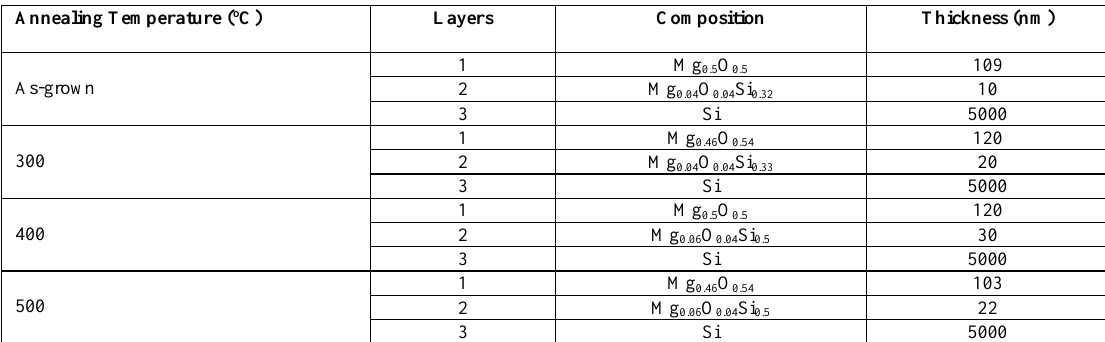
Table 2. Parameters estimated from RBS simulation of MgO film of thickness 50 nm. Layer 1, Layer 2 and Layer 3 are corresponding to MgO layer, diffused layer and Si